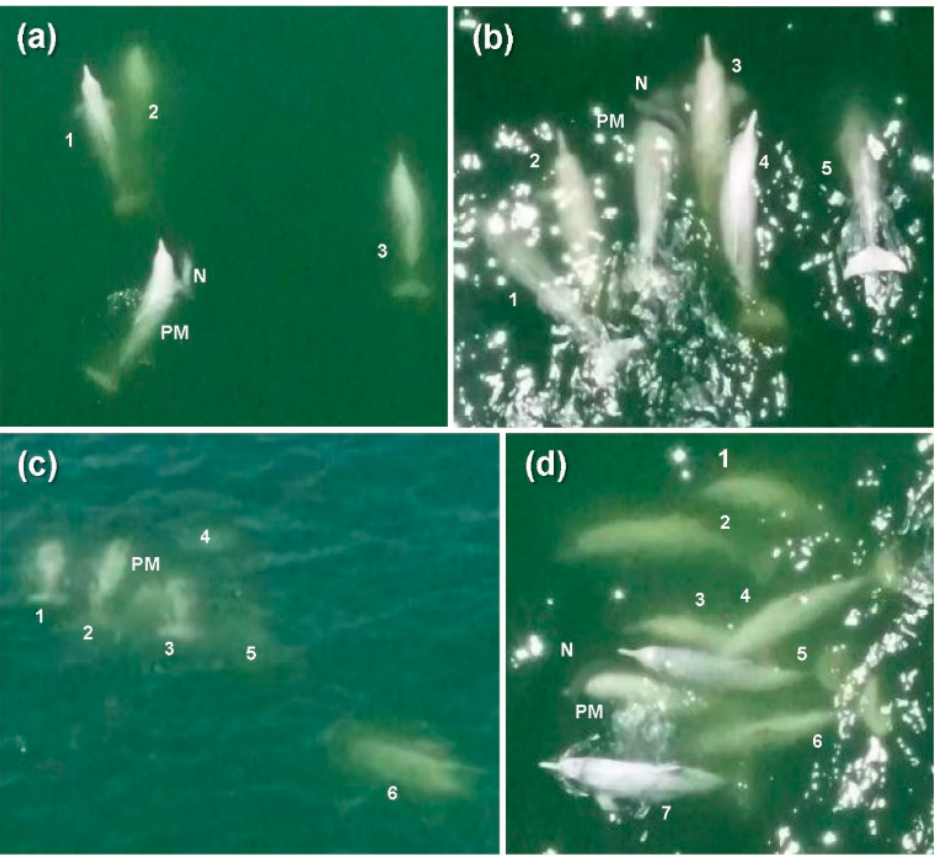
Figure 1. Aerial photographs of the group of Indo-Pacific humpback dolphins Sousa chinensis extracted from the aerial footage. Photographs were extracted at ( a ) 12:55; ( b ) 13:17; ( c ) 13:25; and ( d ) 13:31 to show the gradually increasing number of escorting conspecifics alongside the neonate (N) and presumed mother